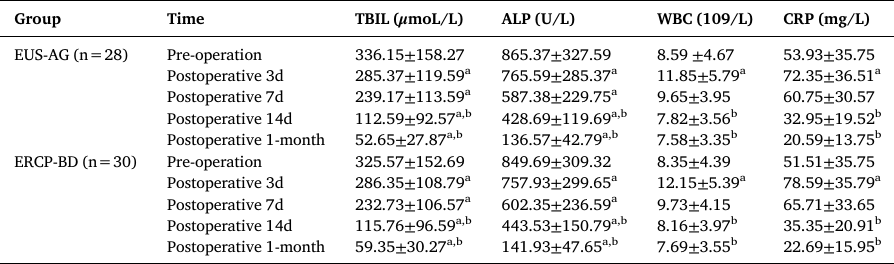
Table 2 The levels of related laboratory indicators before and after treatment in the two groups of patients (X ± s).